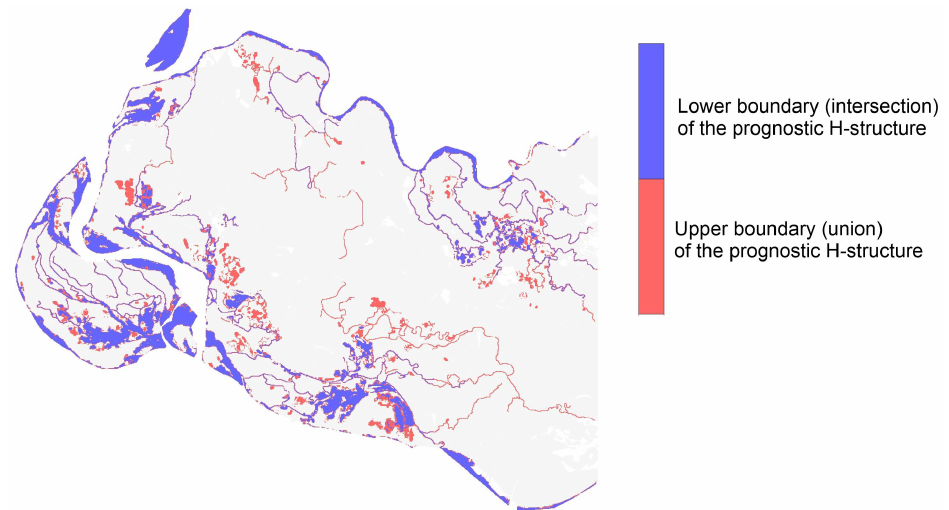
Figure 19. Forecast map of stable flooding of the VAF. The blue color shows the Intersection stable area, while the red color highlights the difference between the intersection stable area and the union stable area.